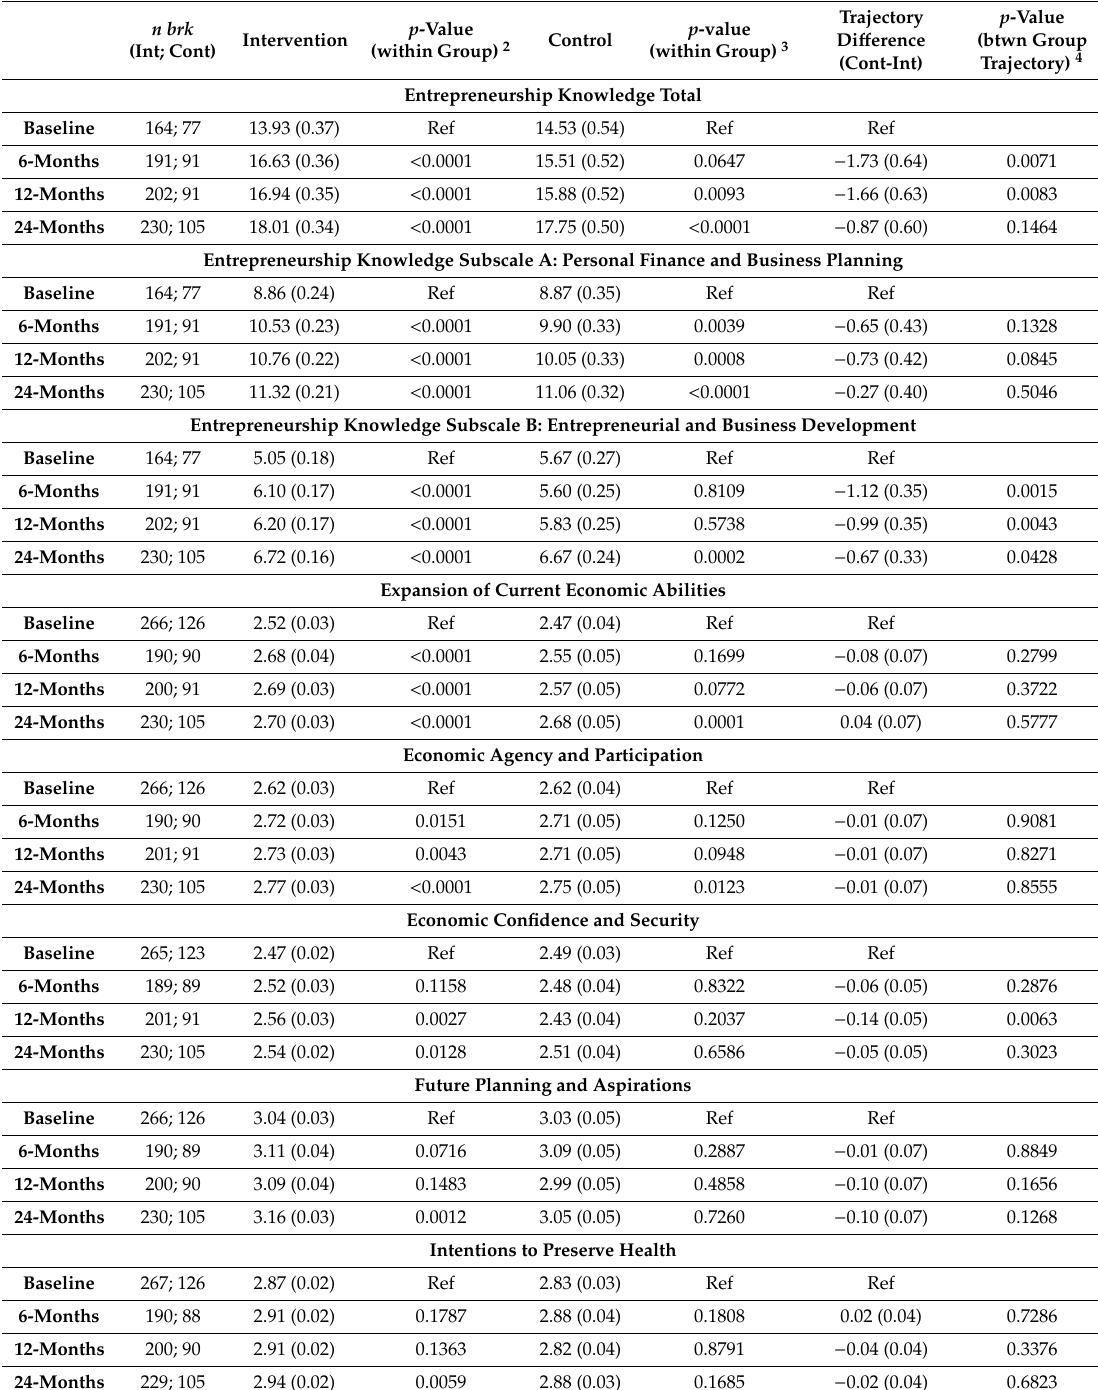
Table 2. Entrepreneurship knowledge and economic empowerment 1